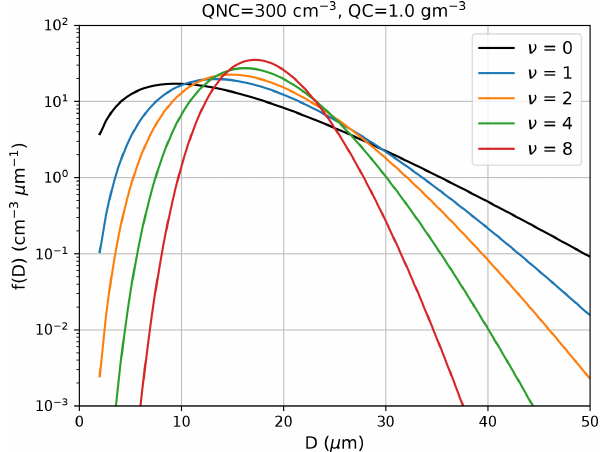
Figure 2. ICON simulation domain and model orography in meters above sea level. The black rectangle depicts the evaluation domain covering most of Germany and parts of neighboring